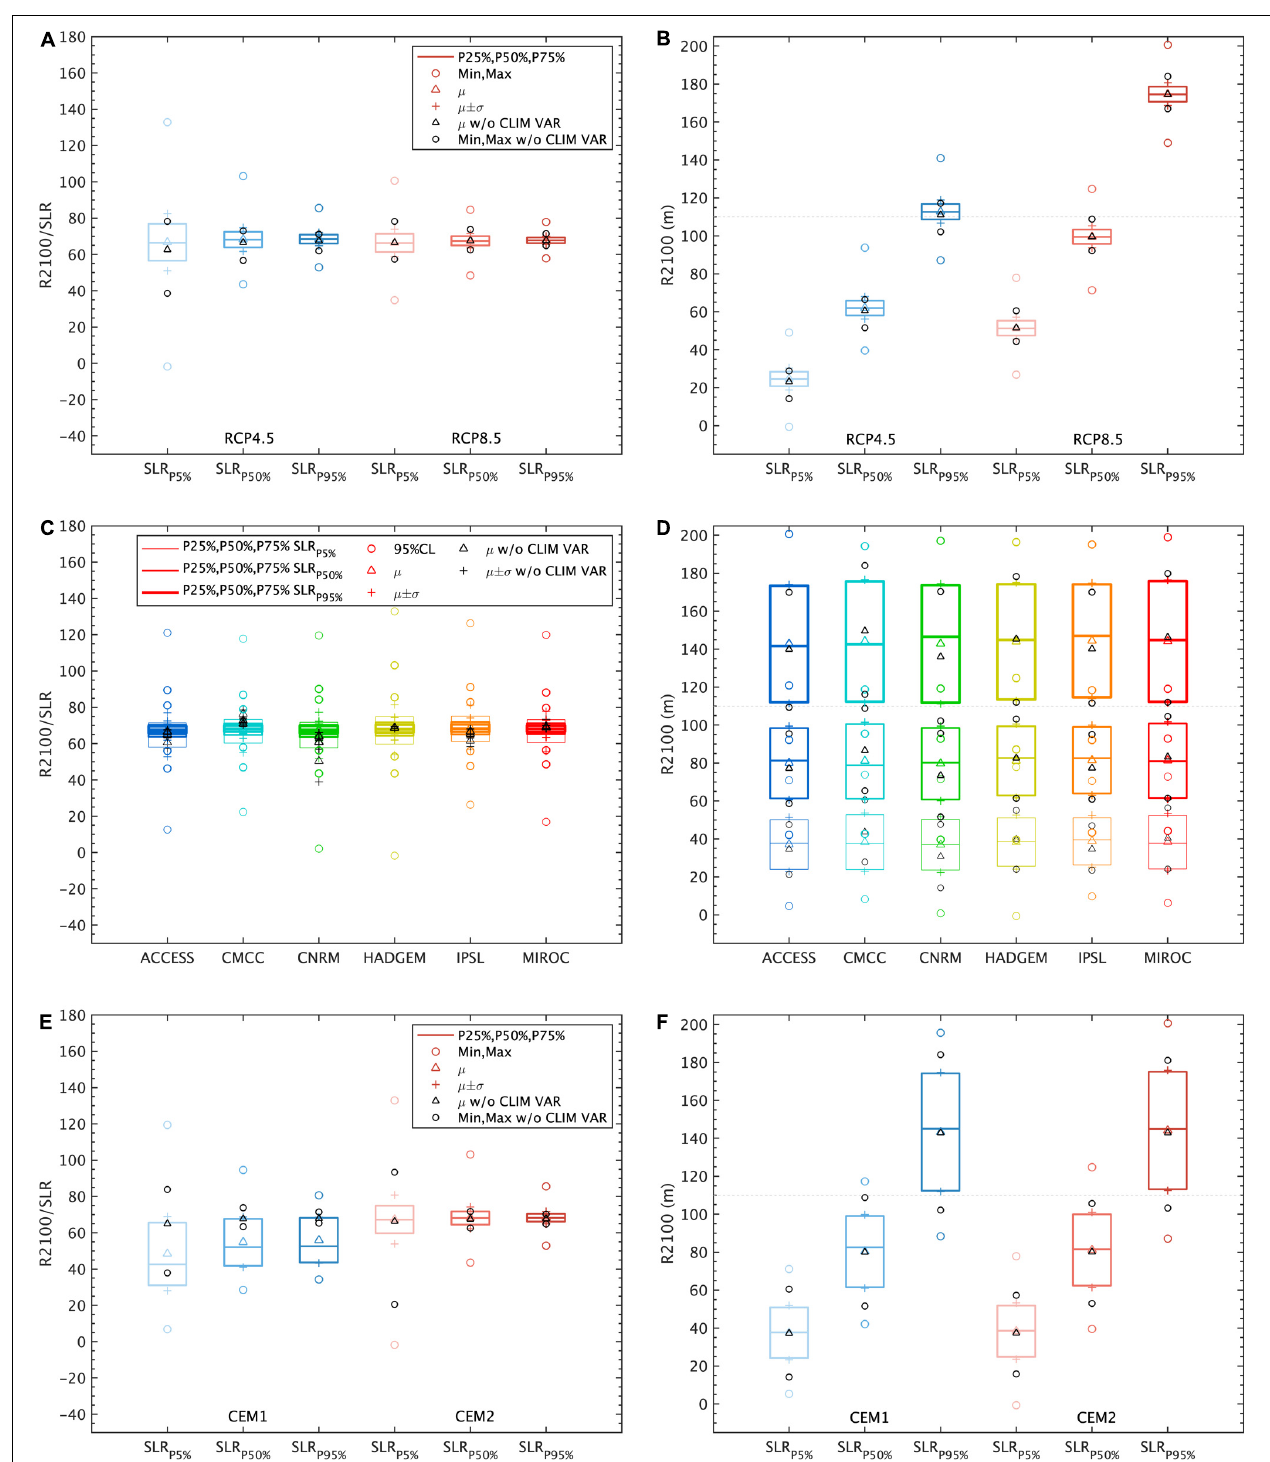
FIGURE 7 | R2100 values factorised by their driving RCPs (A,B) , GCMs (C,D) and CEMs (E,F) , all of them disaggregated in turn by the SLR percentiles (5, 50, and 95th). R2100 factorisation is provided in absolute terms (m) on the right column and nondimensionalised by SLR on the left column. SP1 (72,000 simulations considering climate variability) and SP3 (72 simulations without considering climate variability) are represented using coloured and black symbology, respectively. Note that in B, D and F the grey dashed line represents the threshold beyond which the beach would have disappeared.